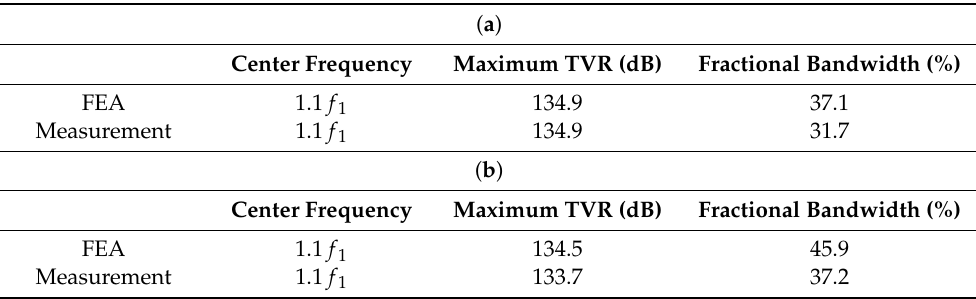
Table 4. Quantitative comparison of the simulated and measured acoustic characteristics of the prototype cymbal arrays: ( a ) initial; ( b ) optimized